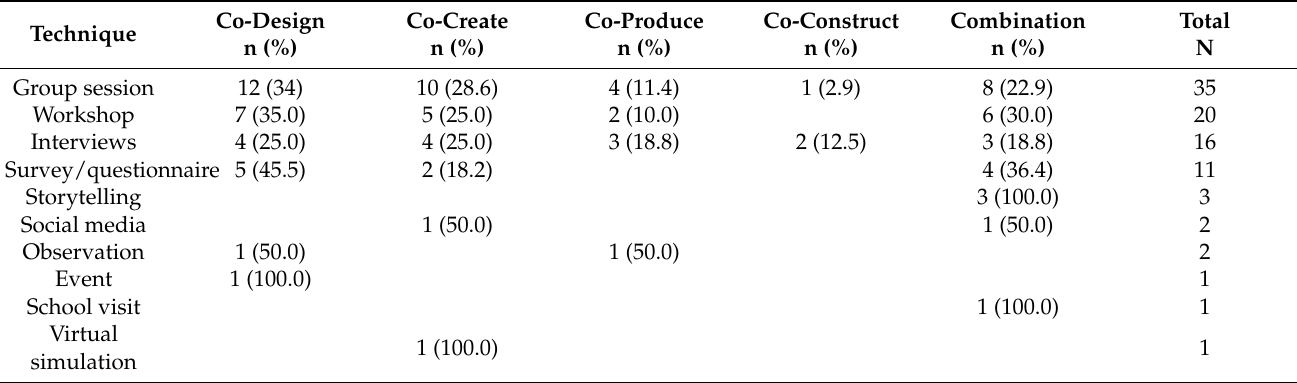
Table 2. Techniques used in co-produced